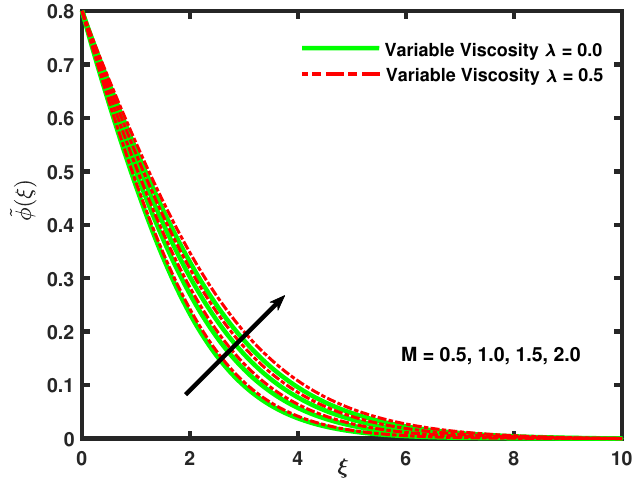
Figure 3. The influence of Magnetic penetrability ( M ) on concentration profile.